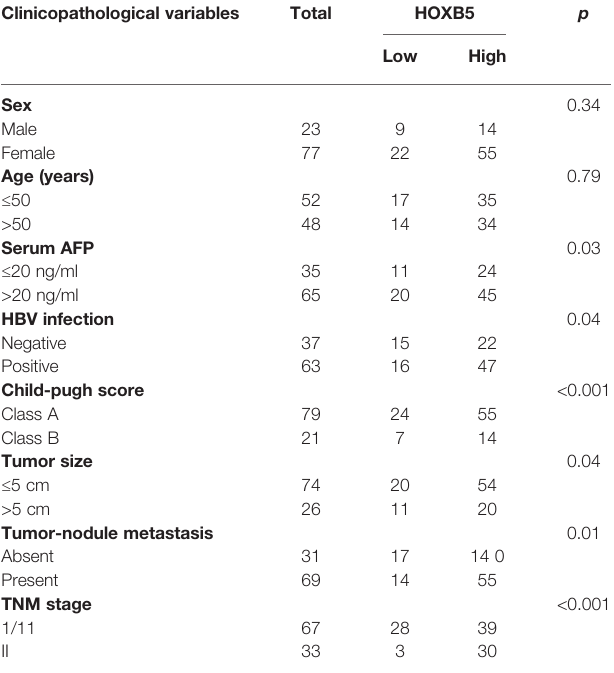
TABLE 1 | Correlation between HOXB5 expression and clinicopathological characteristics of HCC. Clinicopathological